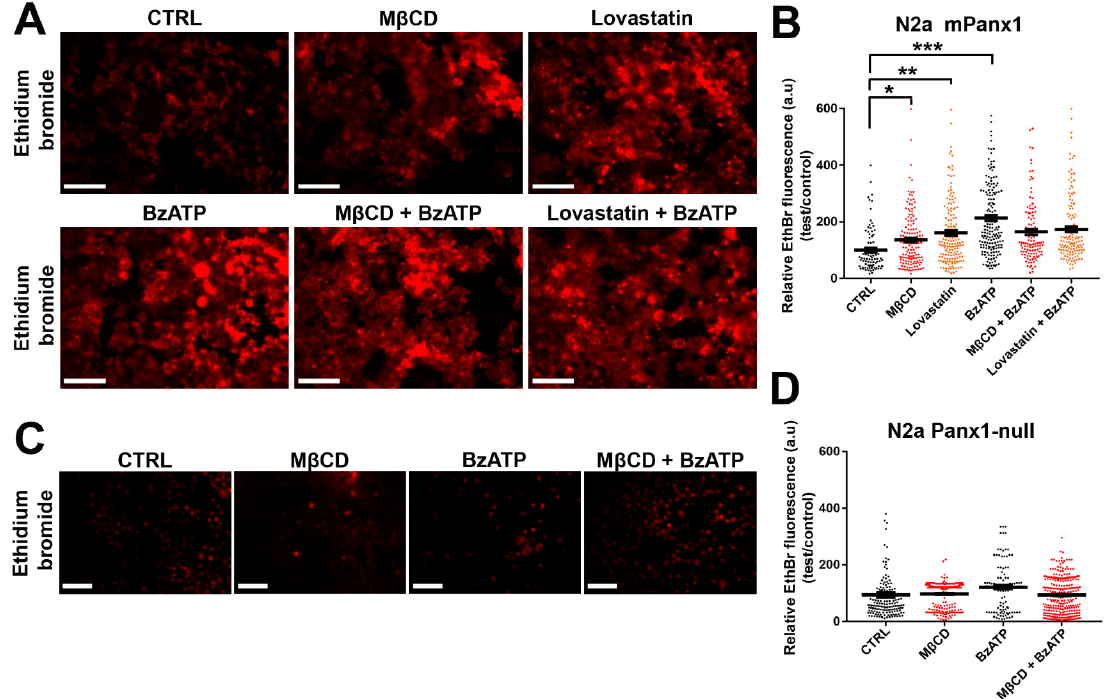
Figure 7. Panx1 channels mediate dye uptake in cholesterol-depleted cell plasma membrane of N2a cells. ( A ) Representative photomicrographs of mPanx1 transfected and Panx1-null. ( C ) N2a cells showing EthBr uptake after M β CD and lovastatin with and without 100 µM BzATP treatment. Scale bar: 100 µm. ( B , D ) Mean ± SEM values of the relative EthBr fluorescence intensity. Values were normalized to those obtained under control conditions. Each point on the graphs represents the mean values of relative EthBr fluorescence changes recorded from all cells present in a field of view